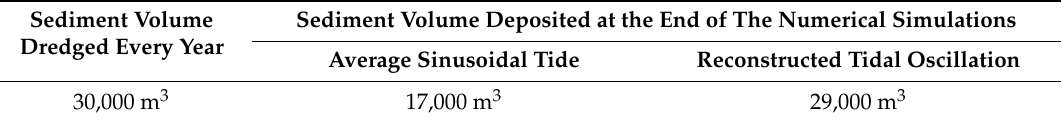
Table 2. Volume of sediments: dredged every year from the Lignano canal and deposited at the end of the numerical simulations performed respectively with the sinusoidal mean tide and the reconstructed tide in conjunction with the considered wind events.